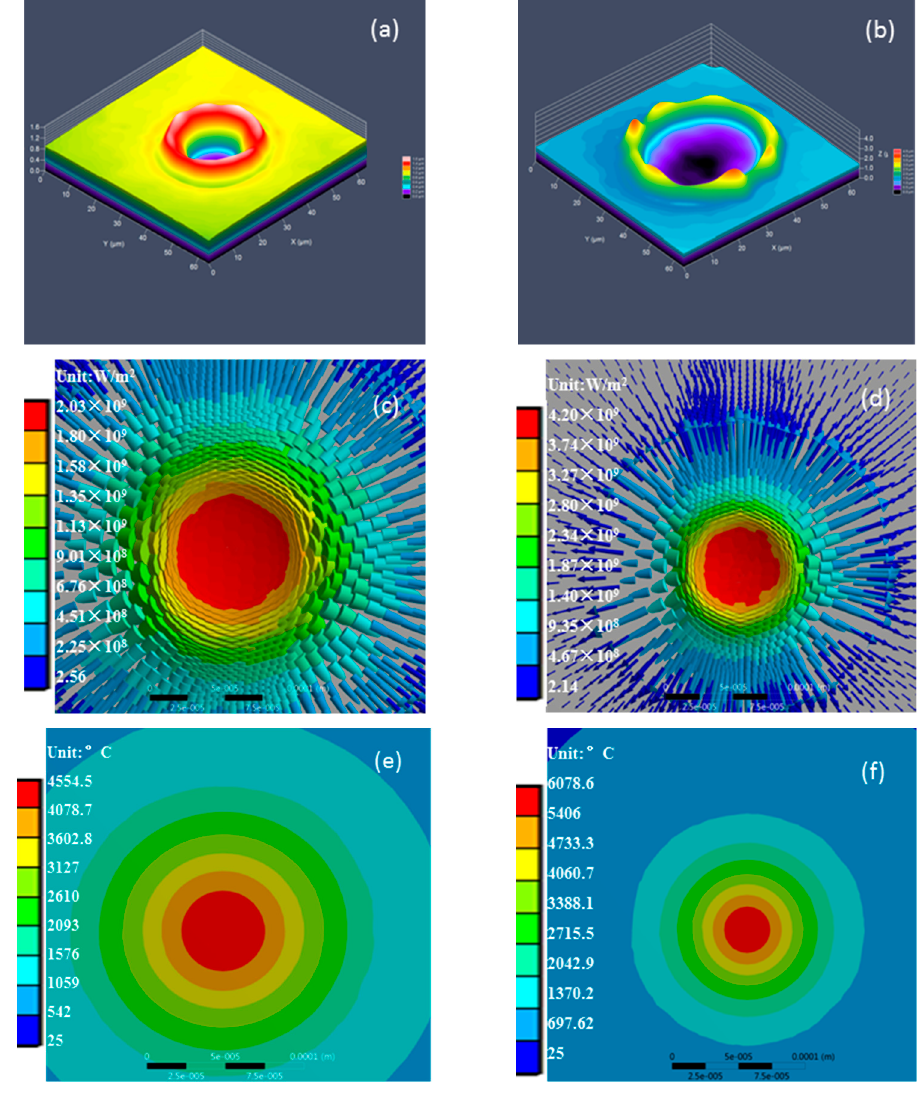
Figure 6. Comparison of the laboratory etch pit morphology with the temperature field and heat flow distribution at different power levels: ( a ) 3D morphology of the pit at 5 W, ( b ) 3D morphology of the pit at 6 W, ( c ) heat flow field distribution at 5 W, ( d ) heat flow field distribution at 6 W, ( e ) temperature field distribution at 5 W, and ( f ) temperature field distribution at 6 W.